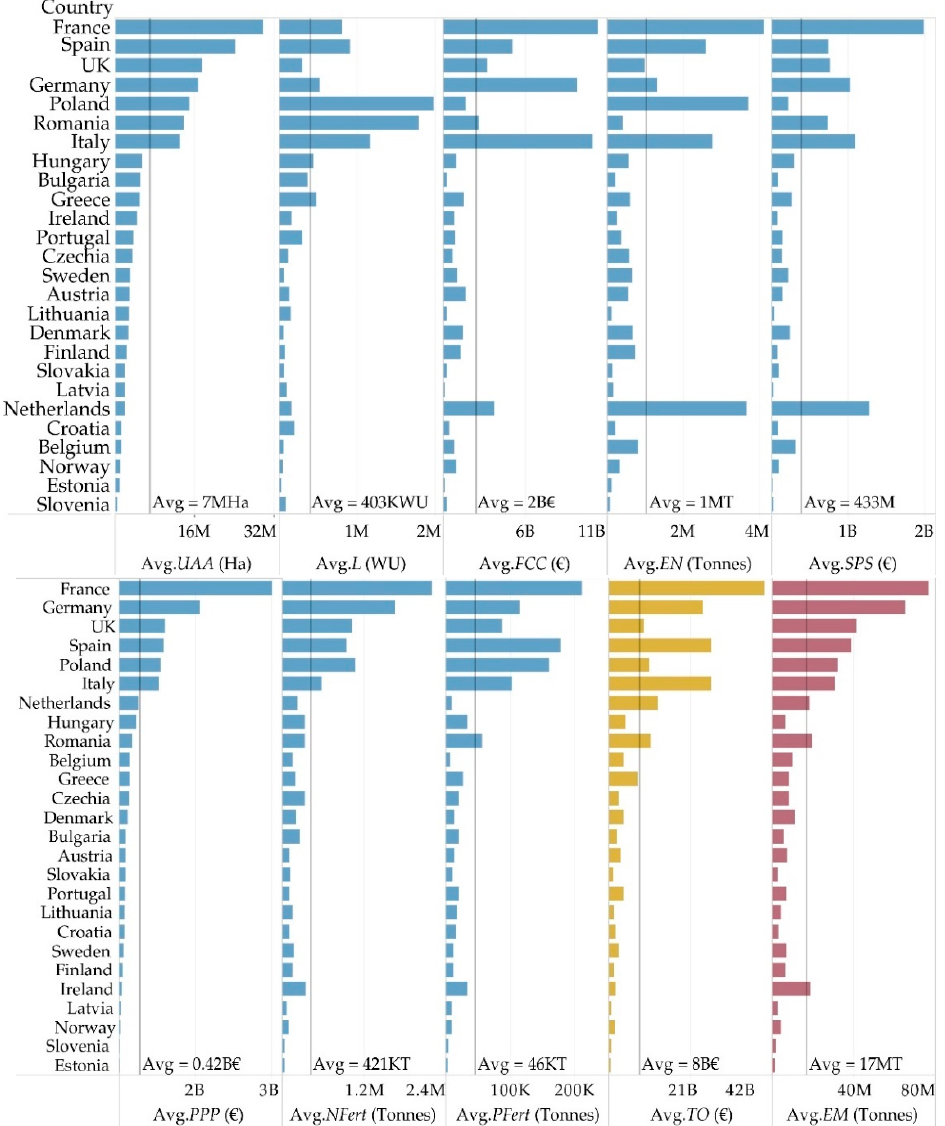
Figure 2. Descriptive statistics of Average Inputs and Outputs per country for reference period 2005–2019.